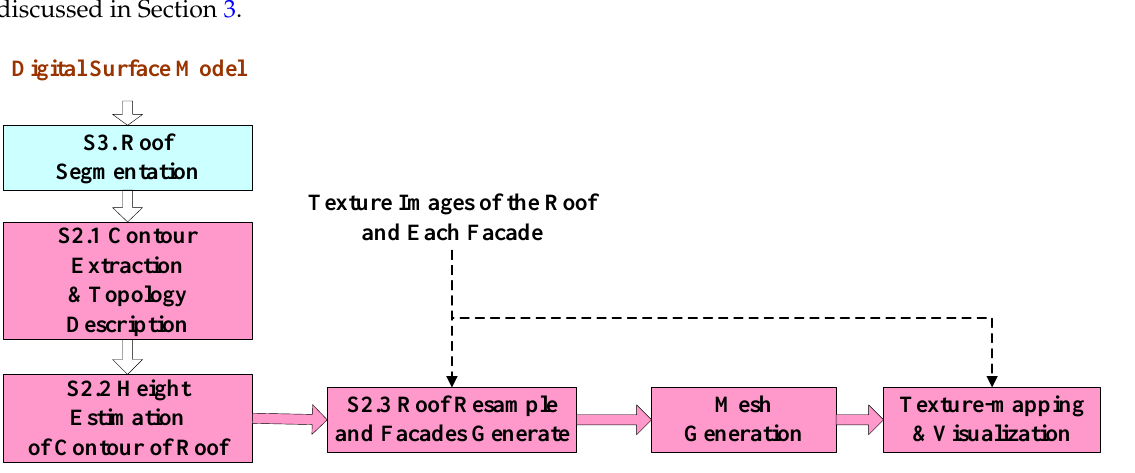
Figure 1. Flowchart of 3D building reconstruction and visualization.